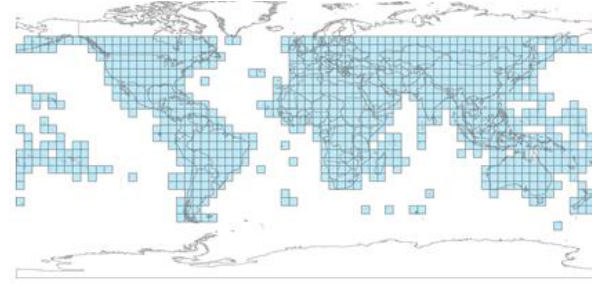
Figure 2. SRTM 90m coverage area used on TIANDITU